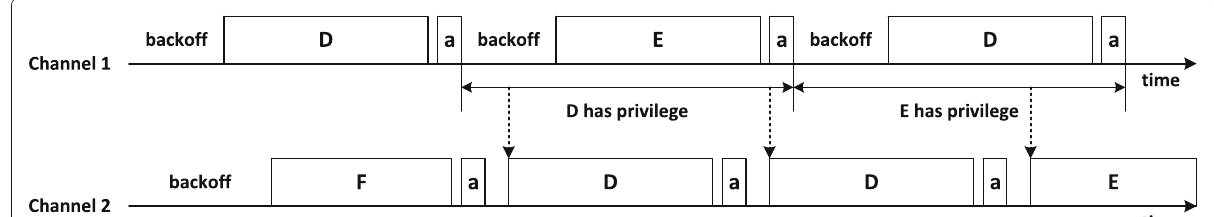
Fig. 5 The second approach for privileged access. If node D wins channel 1, D will transmit on channel 1. When node D successfully sends the packet to its receiver and receives an ACK, it acquires the privilege. The privilege ends when another node successfully finishes transaction on channel 1. In the figure, “a” stands for acknowledgment